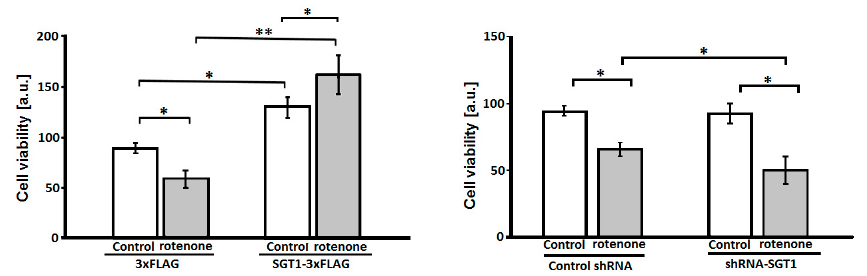
Figure 1. Effect of altered SGT1 level on viability of HEK293 cells treated with rotenone. ( Left panel ) Cells overexpressing SGT1-3 × FLAG or 3 × FLAG were treated with solvent (control, white bar) or rotenone (grey bar). ( Right panel ) Cells transfected with plasmid encoding shRNA against SGT1 mRNA or control shRNA were treated with solvent (control, white bar) or rotenone (grey bar). Cell viability was quantified using MTS assay. Statistical analysis was performed for results obtained from three independent experiments. * p ≤ 0.05; ** p ≤ 0.01.